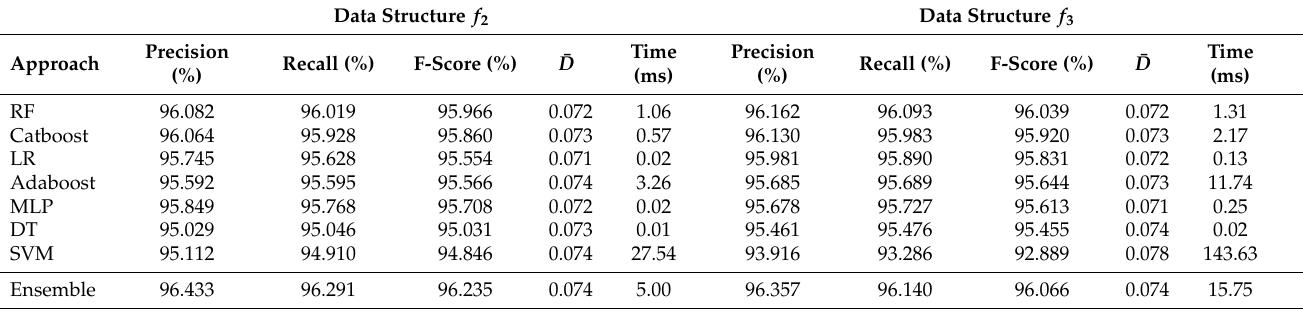
Table 4. Results of the nine classification methods on the GISAID testing dataset S G